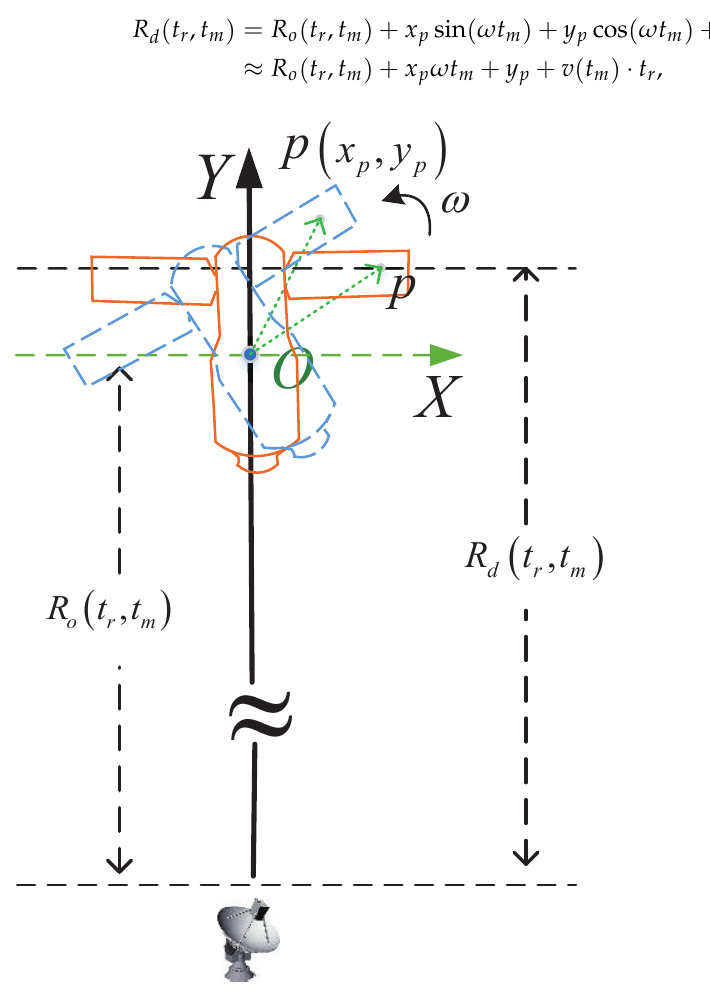
Figure 3. Target’s rotational motion in ISAR